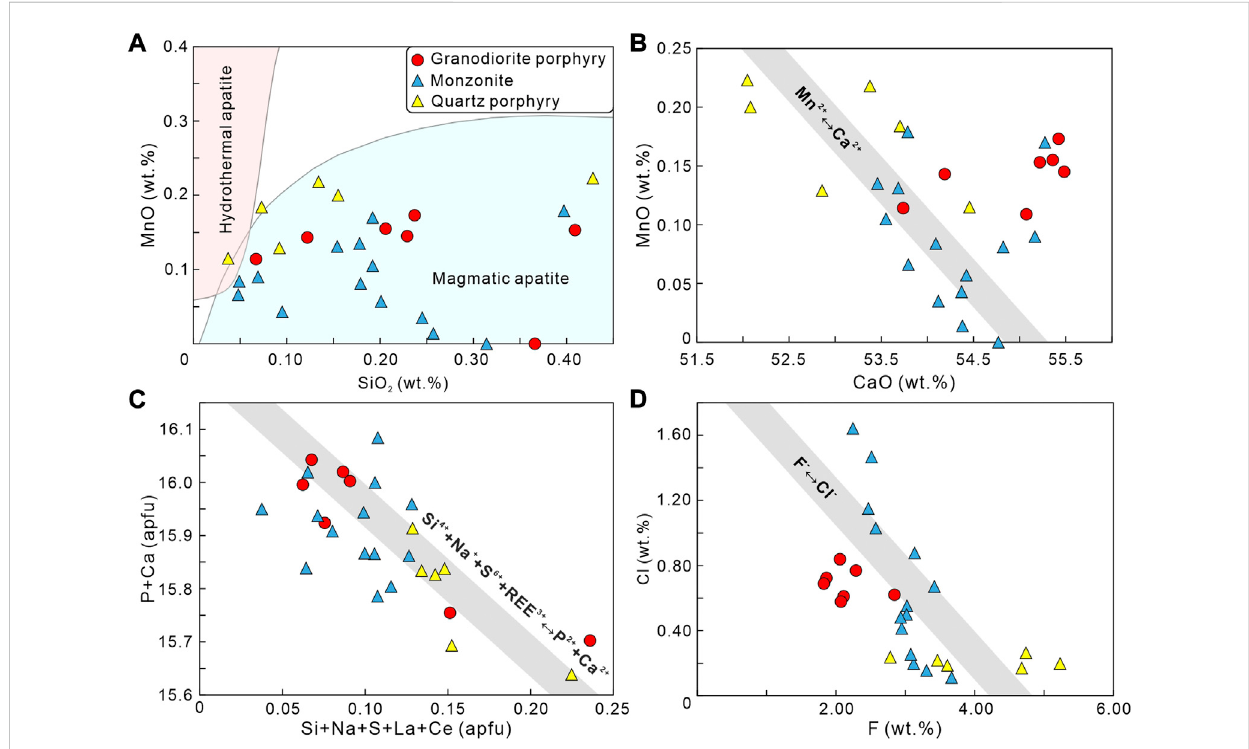
FIGURE 5 (A) Apatite SiO 2 vs . MnO plot; the fi elds of magmatic and hydrothermal apatite are from (Chen and Zhang, 2018); (B) Apatite MnO vs . CaO plot; (C) Apatite P+Ca vs . Si+Na+S+La+Ce plot (calculated according to Ketcham, 2015); and (D) Apatite Cl vs . F